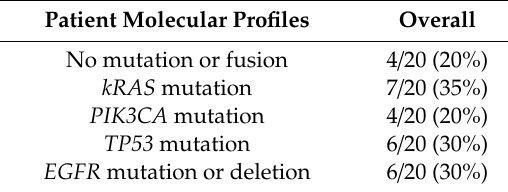
Table 2. Molecular Profiles of NSCLC